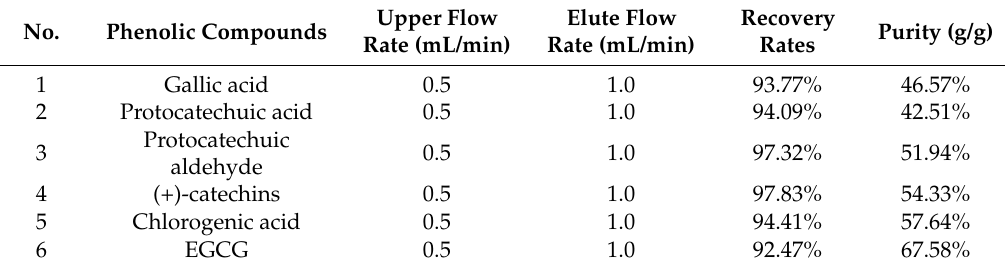
Table 2. Recovery rates of six phenolic compounds by AB-8